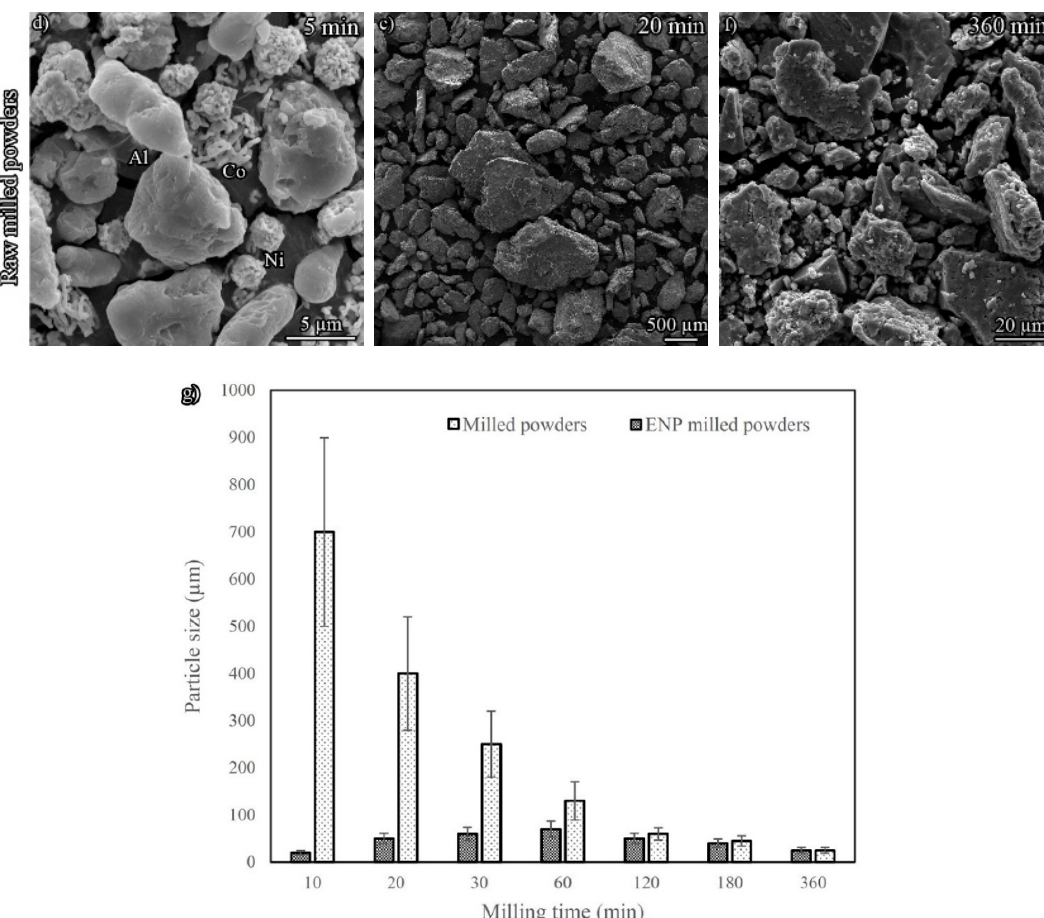
Figure 2. SEM images of particle evolution for both types of the specimens ( a – f ) and their mean size vs. time ( g ) during the milling process.